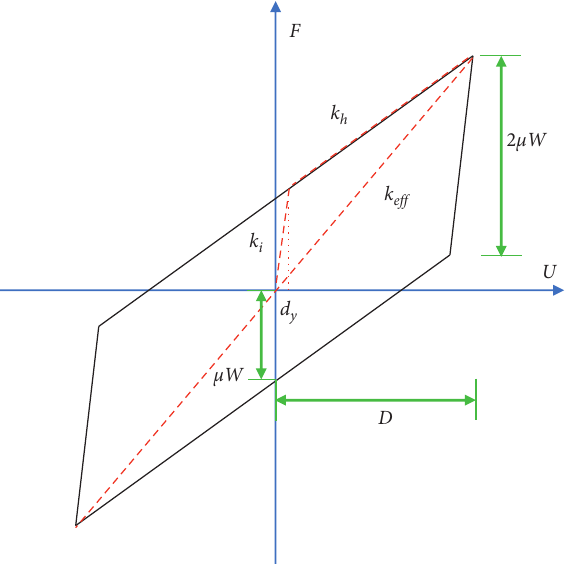
Figure 3: Hysteretic model of